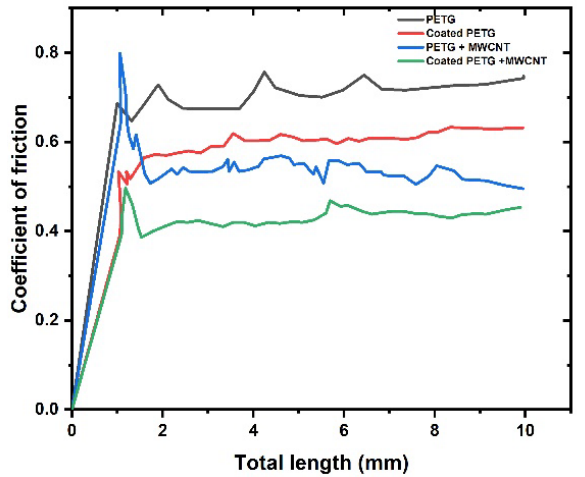
Figure 19. Coefficient of friction vs. total length.